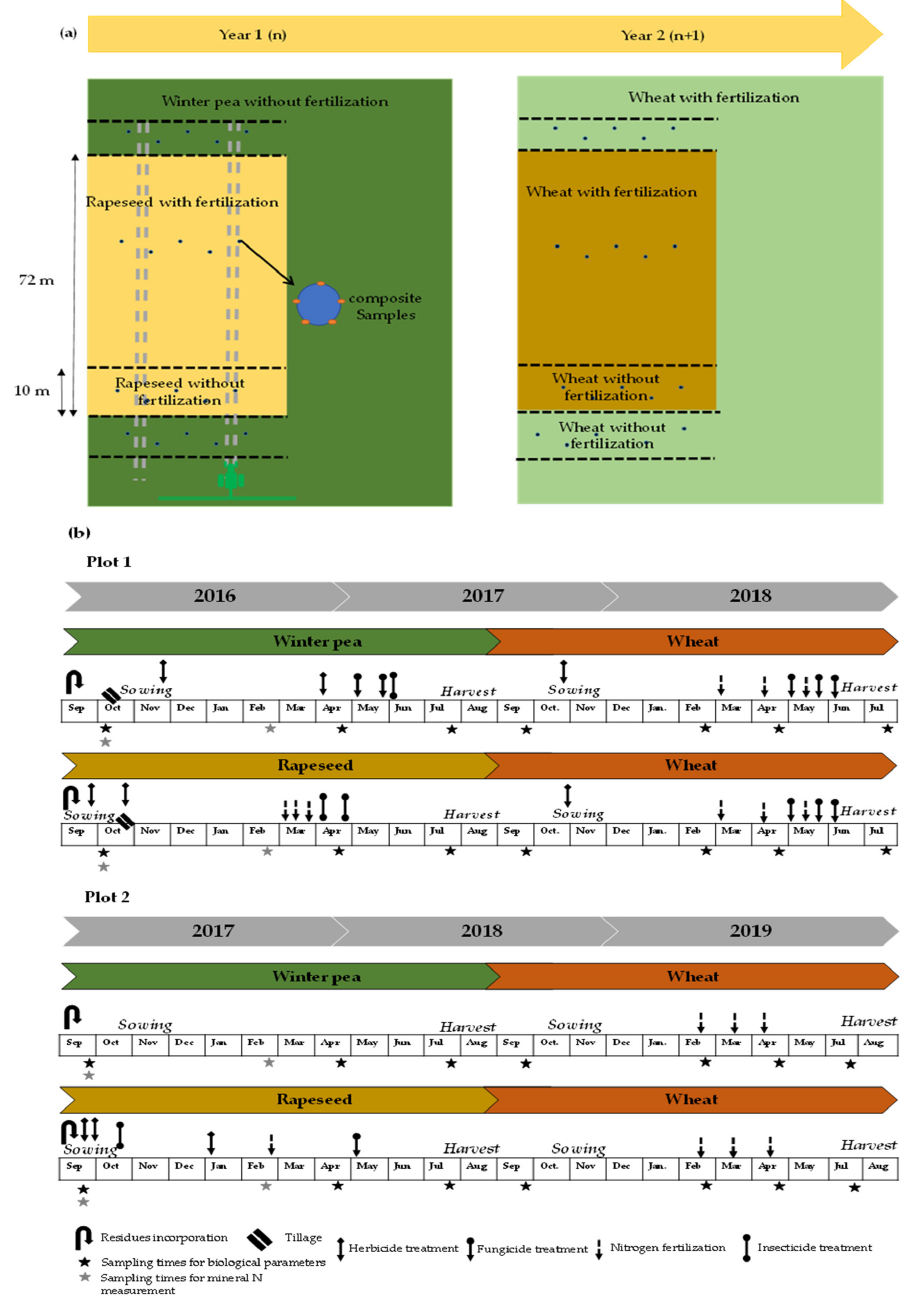
Figure 1. Schematic representation of crop succession including ( a ) plot design implemented in the selected farms (plot 1 and plot 2) and ( b ) history of crop management plan. selected farms (plot 1 and plot 2) and ( b ) history of crop management